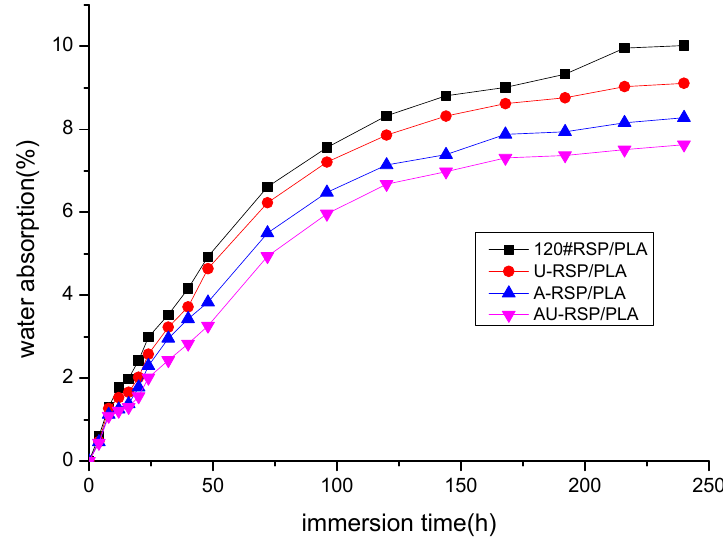
Figure 9. Water absorption curves for unmodified and modified RSP/PLA composites.